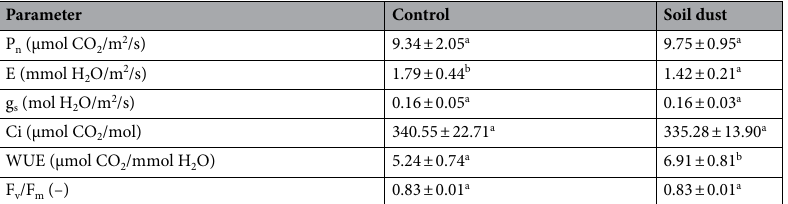
Table 4. Gas-exchange parameters and chlorophyll fluorescence in the control and soil dust treatments. P n : net photosynthetic rate, E: transpiration rate, g s : stomatal conductance, Ci: intercellular CO 2 concentration, WUE: water use efficiency (P n /E), F v /F m : maximum quantum yield of photosystem II (F v /F m = (F m- F 0 )/F m ). Values are means ± SD. Lower-case letters indicate significant differences based on Fisher’s LSD test ( p ≤ 0.05). Data with the same letter are not significantly different.